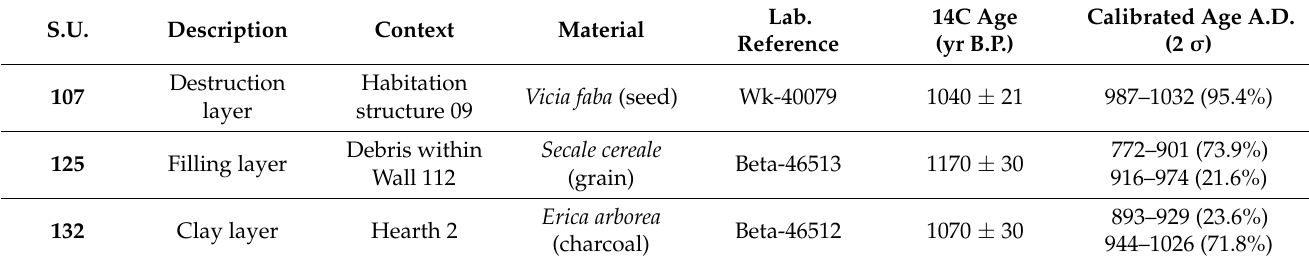
Table 1. Radiocarbon dates obtained from Sector 1 at SB. Calibration Oxcal 4.4.2 software [27], Intcal 20 calibration curve